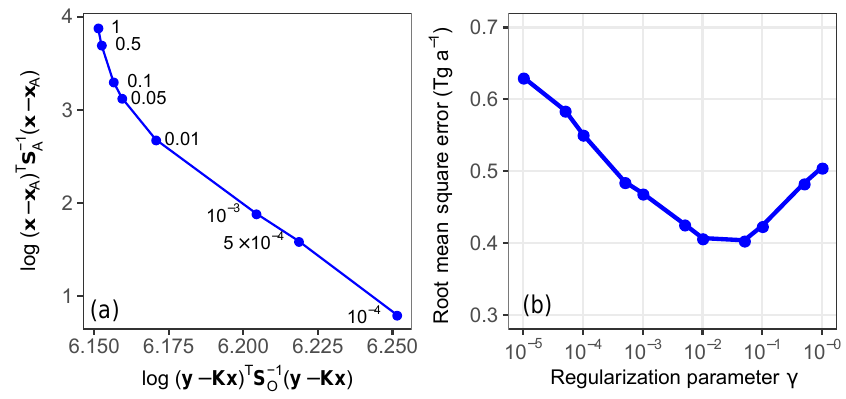
Figure 5. Optimization of the regularization parameter γ in Eq. (4) for the SWIR + TIR satellite observing system. (a) L-curve plot (log–log plot of the squared errors of a regularized solution versus corresponding residual). Values of γ corresponding to each point are indicated. The “turning corner” of the curve indicates an optimal choice of γ (Hansen, 2000). (b) Ability of the inversion to match the true gridded methane emission field as a function of the regularization parameter. The ability is measured by the RMSE.